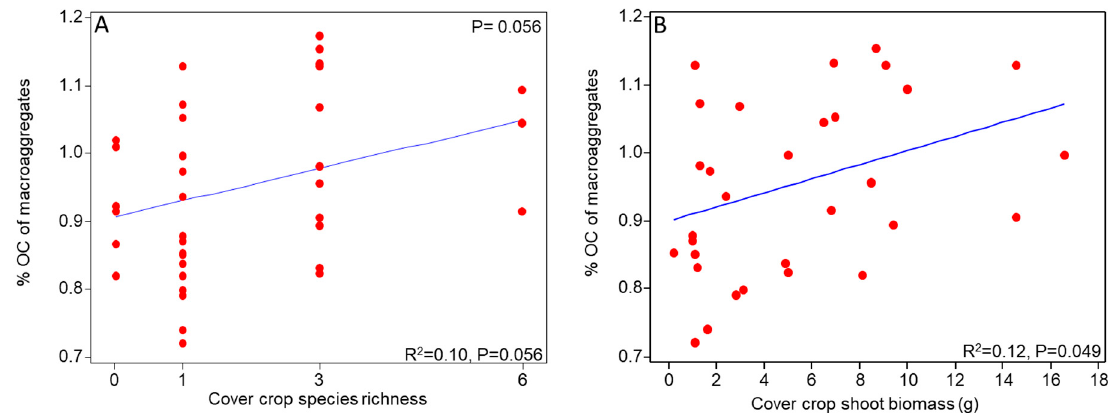
Figure 2. Impact of cover crop species richness on OC contents of soil macroaggregates ( A ). The relationship between cover plant shoot biomass and OC contents of soil macroaggregates ( B ).